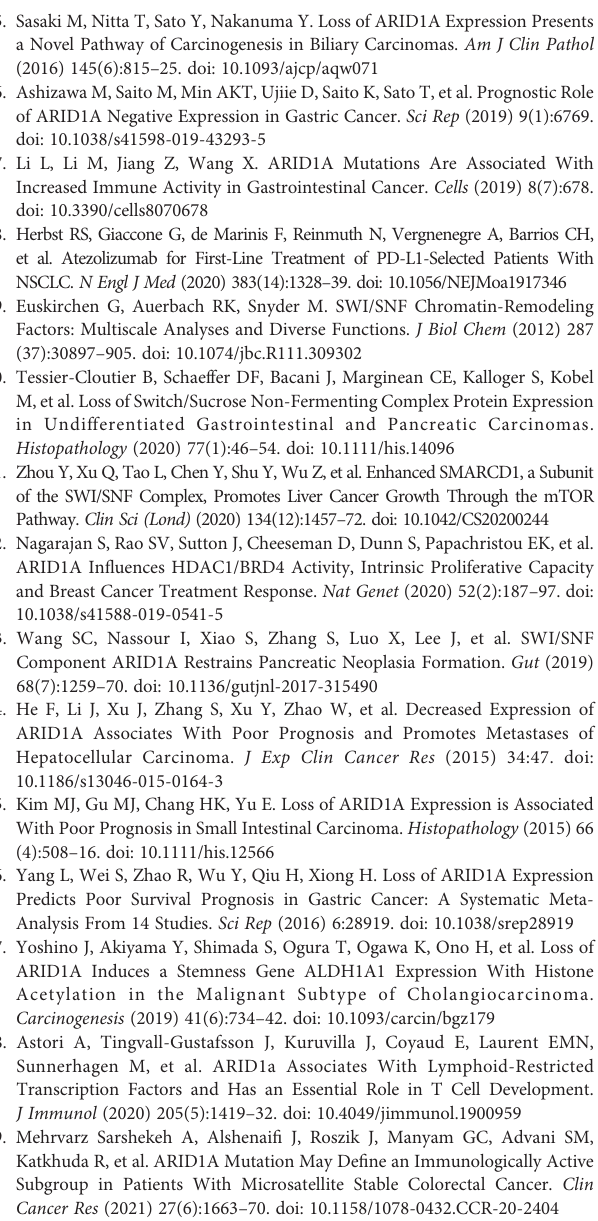
Supplementary Figure S1 | Effects of PD-L1 expression and PD1+ tumor in fi ltrating lymphocytes (TILs) on overall survival (OS) in patients with gallbladder cancer. (A) The OS curves of patients with high or low PD-L1 expression. (B) The OS curves of patients with high or low PD1+ TIL in fi ltration. Supplementary Figure S2 | The comparison of CD8+ cells and PD1+ tumor in fi ltrating lymphocytes (TILs) in samples with high/low expression of